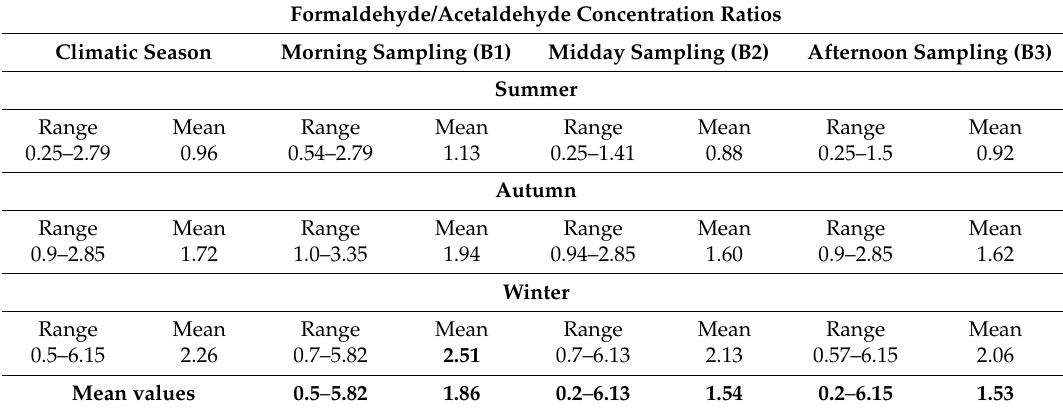
Table 4. Formaldehyde/acetaldehyde concentration